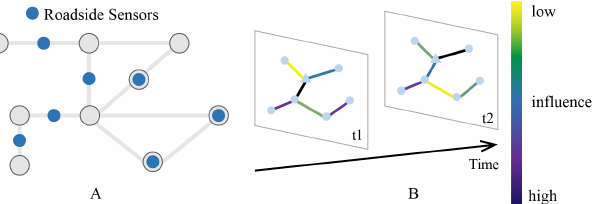
Figure 3. Association between nodes. Subfigure ( A ) shows the distribution of each sensor in a road network. Subfigure ( B ) shows the correlation degree changing over time.